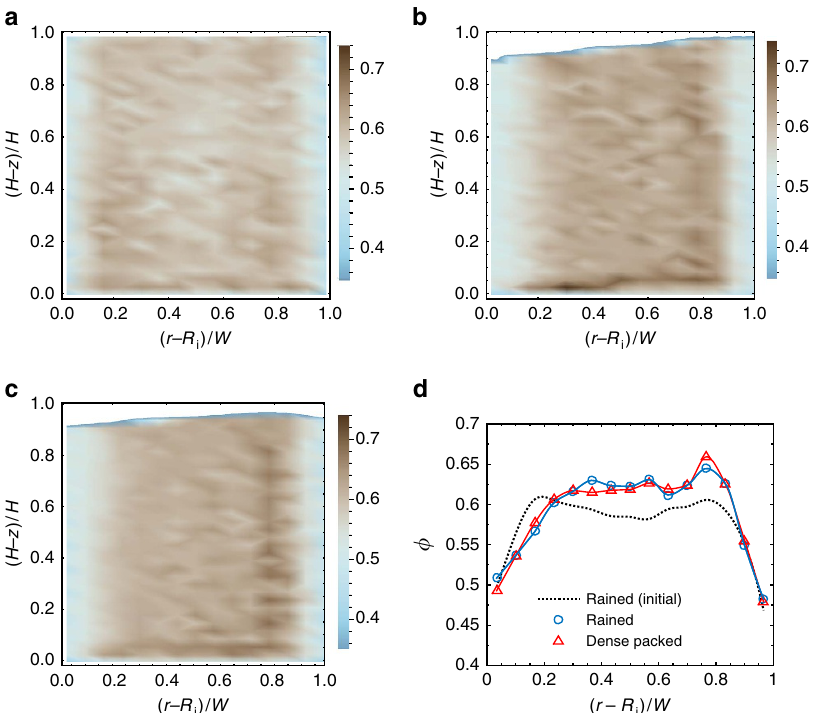
Figure 3 | Density distribution and dilation. ( a – c ) Distribution of the solids fraction f before commencement of shear after filling by raining ( a ), at the sheared steady state after filling by raining ( b ), and at the sheared steady state after filling by dense packing ( c ). The colours indicate the value of f . ( d ) The radial profile of f at z ¼ 15 d p . The results in all the panels are for fill height H ¼ 30 d p and rough